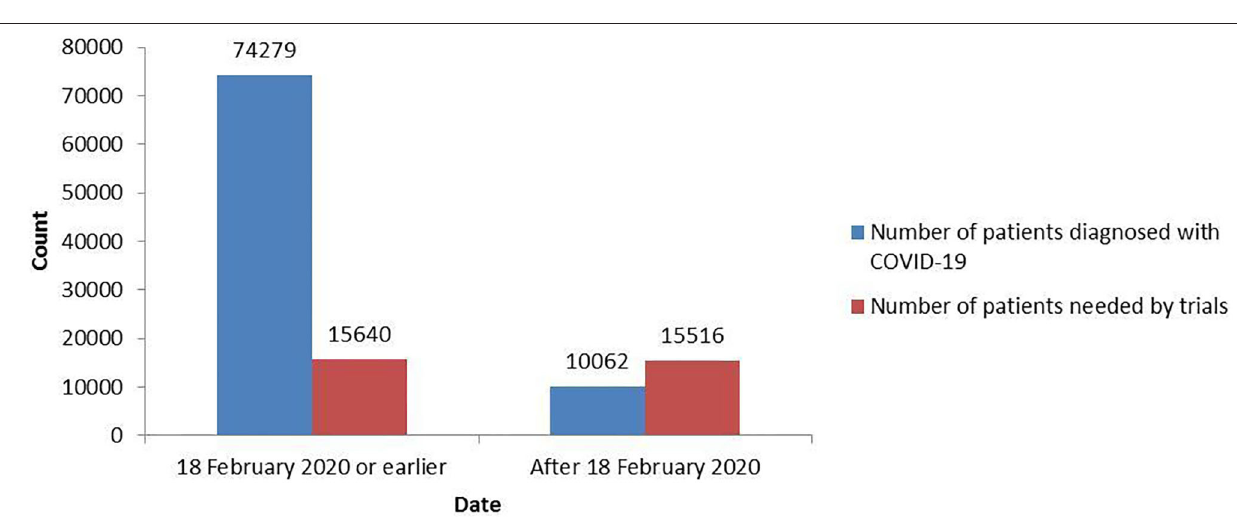
FIGURE 2 | The total number of patients needed by the COVID-19 trials and the total number of patients diagnosed with COVID-19 before and after 18 February